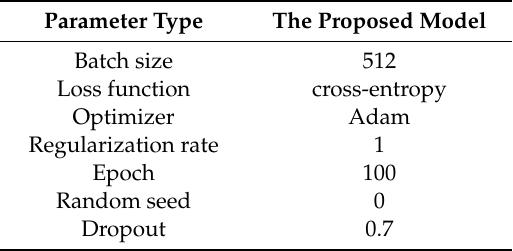
Table 3. Parameters of the proposed